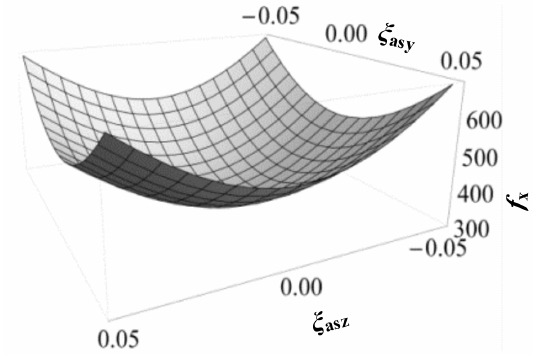
Figure 7. Variation of actuation force, f x , with ξ asy and ξ asz , when ξ asx =